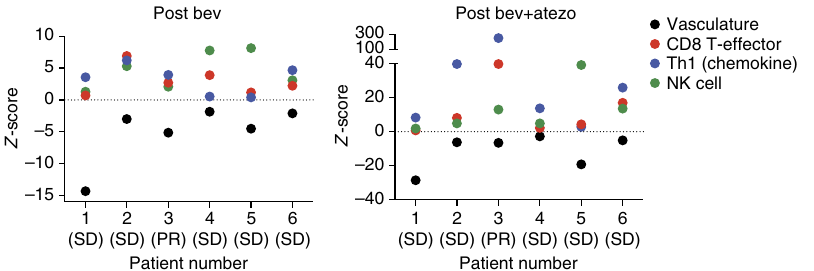
Figure 2 | Gene expression tumour biomarkers following treatments. Levels of on-treatment tumour samples are shown relative to the baseline levels (dotted line) for the patients where the pre-treatment, post-bevacizumab (bev; blue circles) and post-combination biopsies were collected. Vascular signature genes ( ANGPT2 , CD34 , DLL4 , EGFL7 and ESM1 ) are shown in black, CD8 Teffector genes ( CD8A , CD8B , EOMES , GZMA , GZMB , IFNG and PRF1 ) are shown in red, Th1 chemokines ( CXCL10 , CXCL11 , CXCL13 and CXCL9 ) are shown in blue and natural killer (NK) cell genes ( GZMB , KLRK1 and SLAMF7 ) are shown in green. atezo,